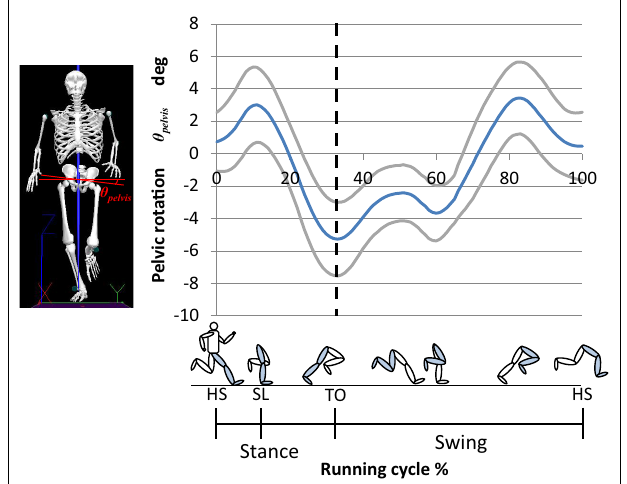
FIGURE 1 | Human pelvic rotation in the frontal plane during running . To compare the time course changes in joint angles between trials and among subjects, the time-series data were time normalized to 101 data points, with each time interval representing 1% of the stance phase (mean, solid blue line; SD, solid gray line). First, at heel strike, the angle of the pelvis is 0.7°. Then, the pelvis rotates up to 3.0° until landing of the sole. Subsequently, the pelvis rotates in the opposite direction up to (cid:0) 5.3° until takeoff using the toe. After takeoff, the pelvis rotates to the initial angle for landing with the other leg. HS, heel strike; SL, sole landing; TO, toe